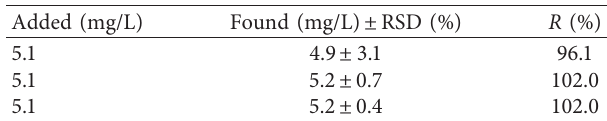
Table 2: Analytical performance data for the Cu 2+ determination